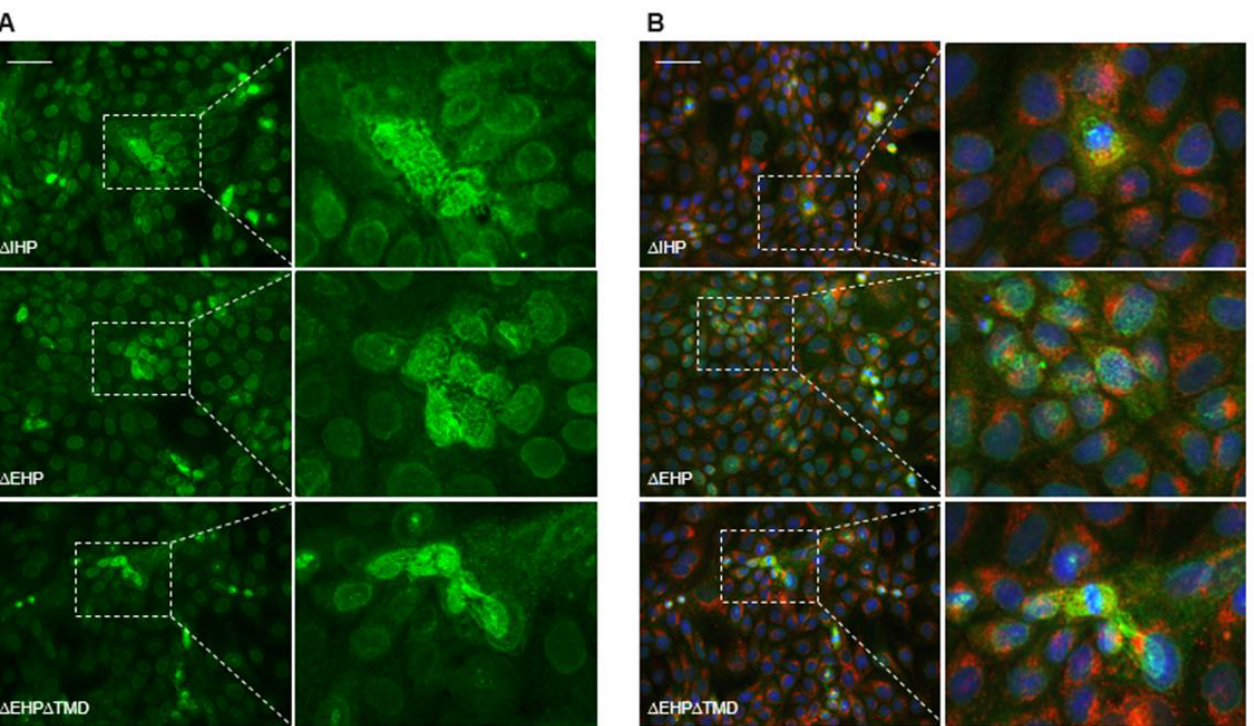
Figure 4. Deletion of the EHP or IHP lead to the formation of intracellular polymers. ( A ) Immunofluorescence analysis of permeabilized MDCK cells stably expressing different ZPLD1 mutant isoforms. In contrast to findings for Uromodulin [23], intracellular assembly of mutant protein can be observed for all three investigated variants. Bar, 50 µm; ( B ) Immunofluorescence of MDCK cells stably expressing ZPLD1 IHP and EHP mutant proteins. Permeabilized cells were incubated with anti-Strep, anti-GM130 Golgi marker and DAPI. The presented merged pictures show Strep (ZPLD1) and GM130 signals in green and red, respectively. DAPI cell nucleus staining is shown in blue. Intracellular filaments formed by the mutant protein do not colocalize with GM130. Bar, 50 µm.